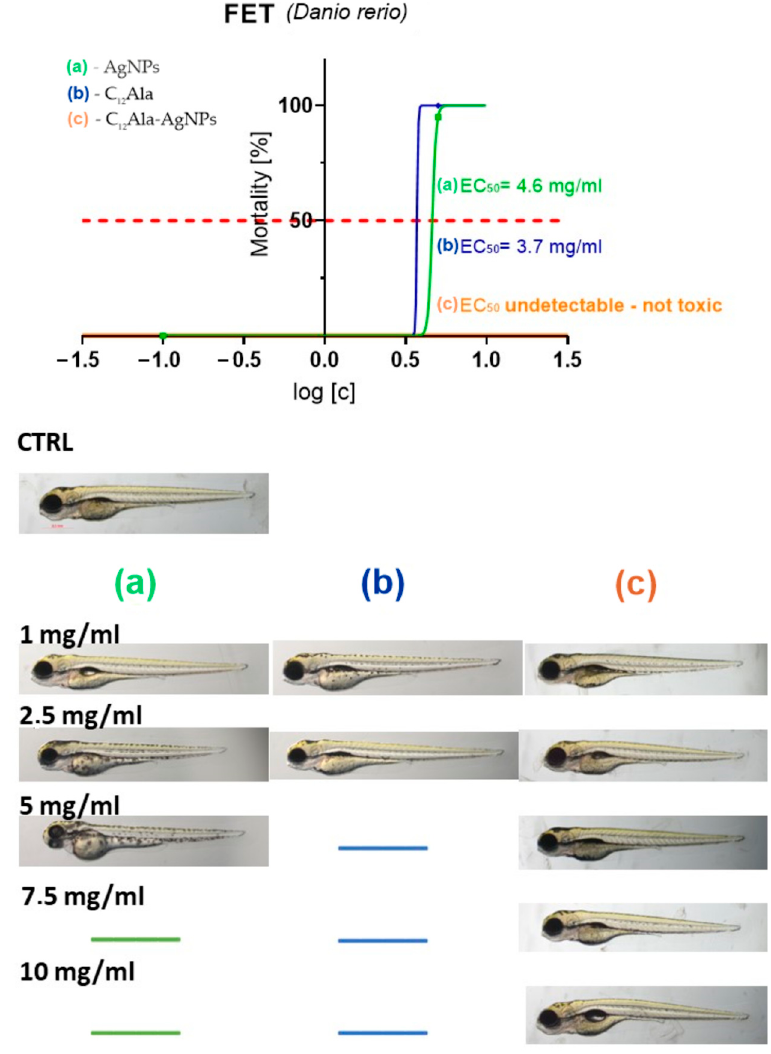
Figure 12. Determination of the fish embryo toxicity (FET), expressed as EC 50 values, and the effect of the tested compounds on the morphology of zebra-fish embryos. ( a ) AgNPs, ( b ) C 12 Ala, ( c ) C 12 Ala-AgNPs.